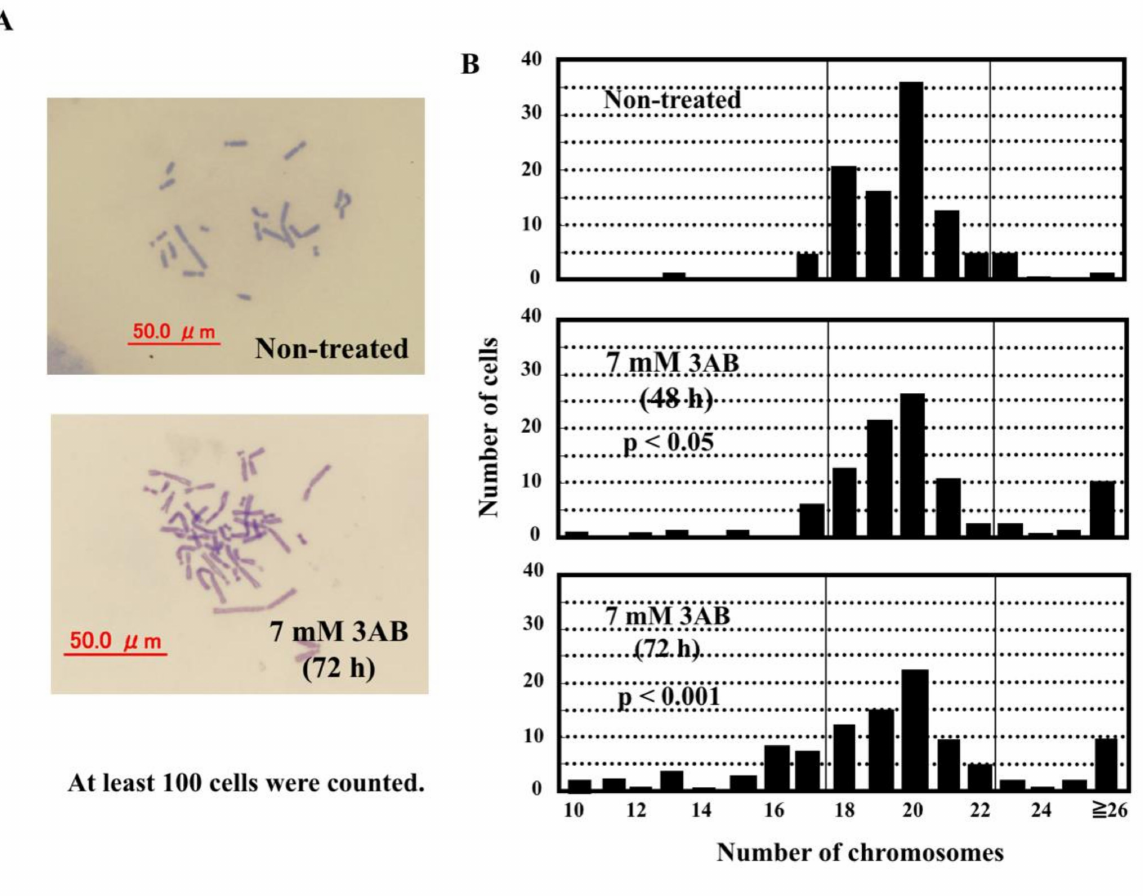
Figure 3. 3AB, a PARP inhibitor, induced aneuploidy of chromosomes. ( A ) Photograph of metaphase of cells treated with or without 7 mM 3AB for 72 h. ( B ) Histogram of cells (%) with a defined number of chromosomes. At least 100 metaphases were analyzed. The number of cells with chromosome number outside of the range of 20 ± 2 was judged as abnormal. Significance was analyzed with Fisher’s exact